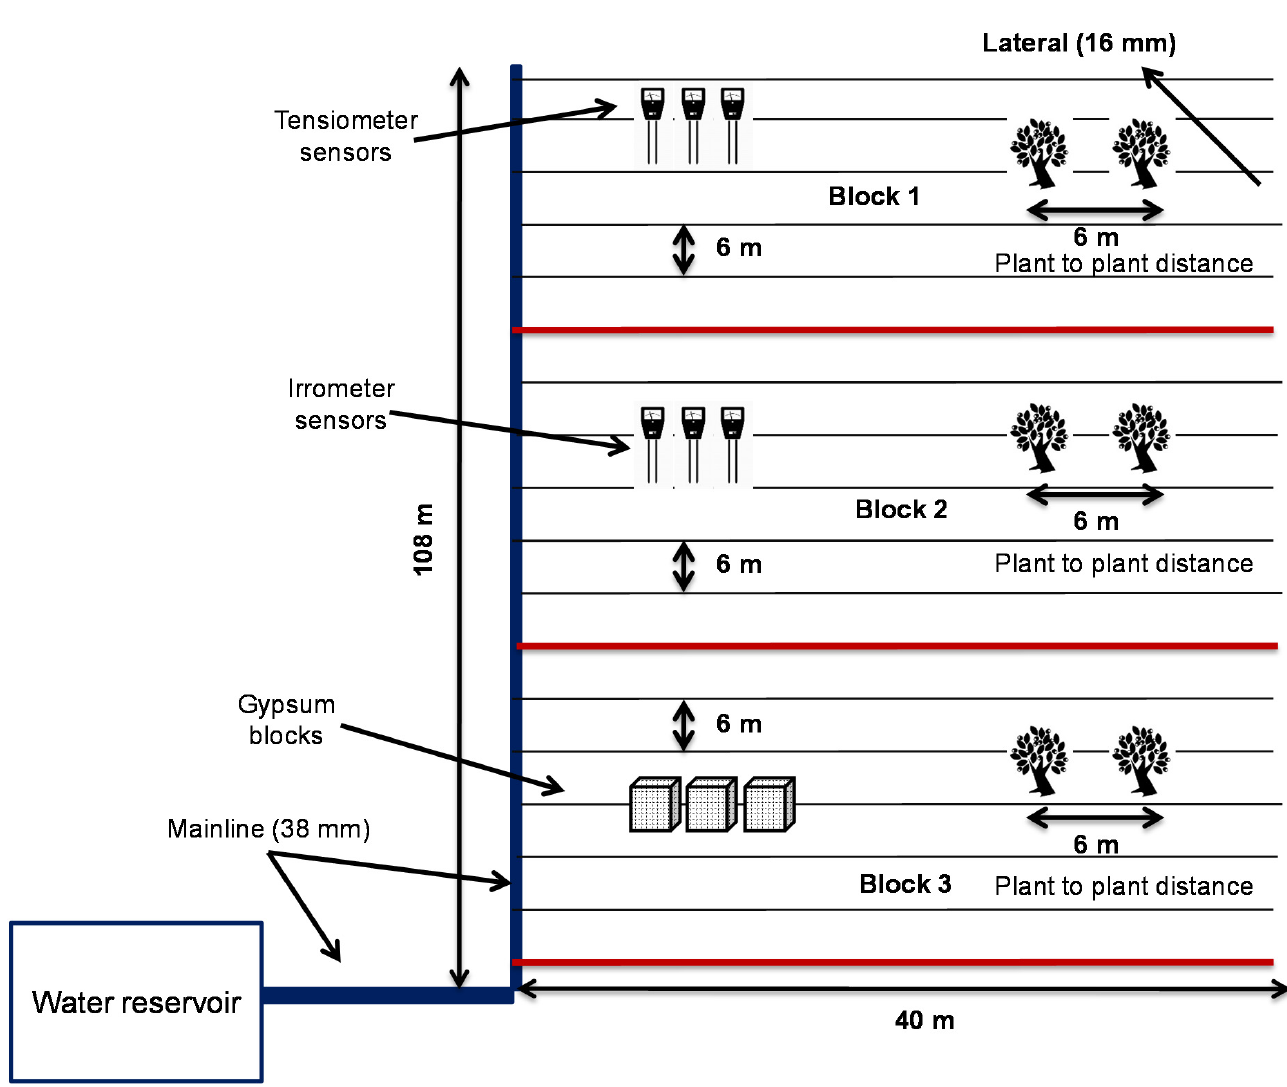
Figure 4. Experimental layout used in this study.